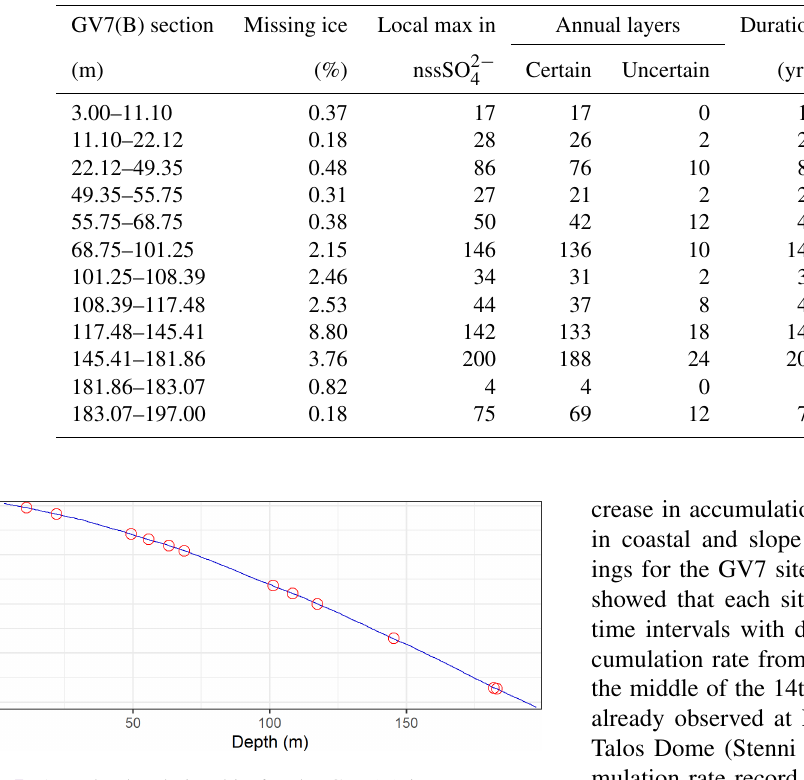
Figure 5. Age–depth relationship for the GV7(B) ice core. Tem- poral horizons used as constraints in the dating procedure are high- lighted with red